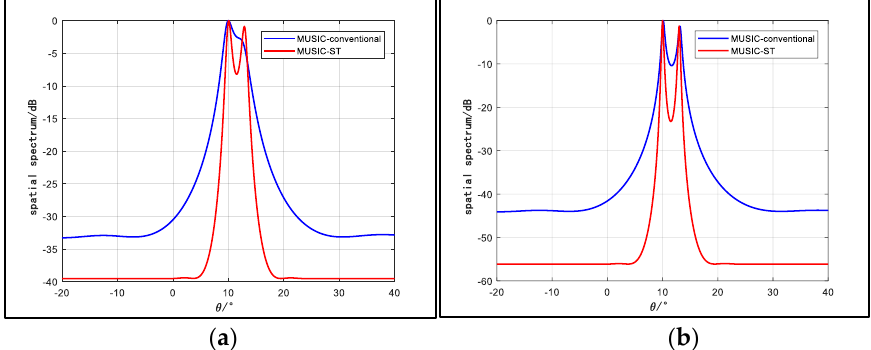
Figure 1. Spatial spectrum for different SNRs: ( a ) SNR = 2dB; ( b ) SNR = 10dB. Figure 2. Spatial spectrum for different SNRs: ( a ) SNR = 2dB; ( b ) SNR =